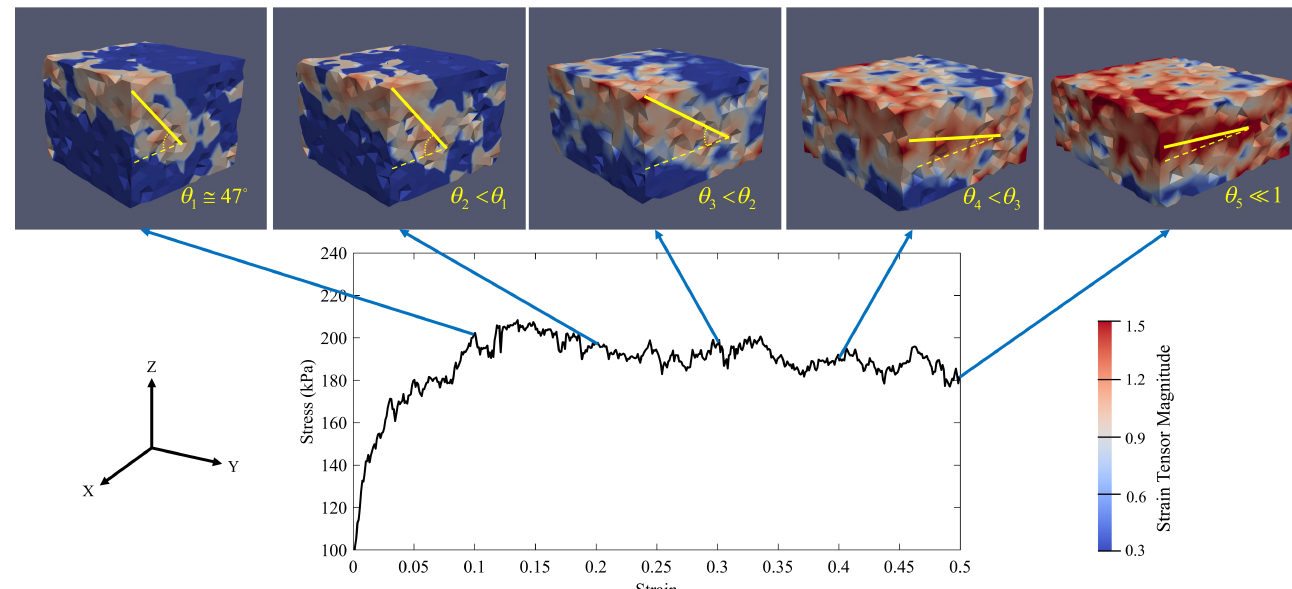
Figure 16. The evolution of micro-strain of specimen S 1 during the compaction process according to its stress-strain diagram ( P 0 = 100 kPa and ˙ (cid:101) 3 = 0.05 s − 1 , θ i = the angle between the localized band and the maximum principal stress